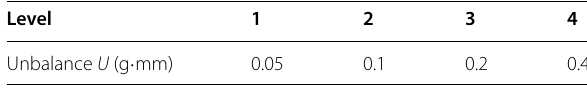
Table 4 Four different magnitudes of induced unbalance